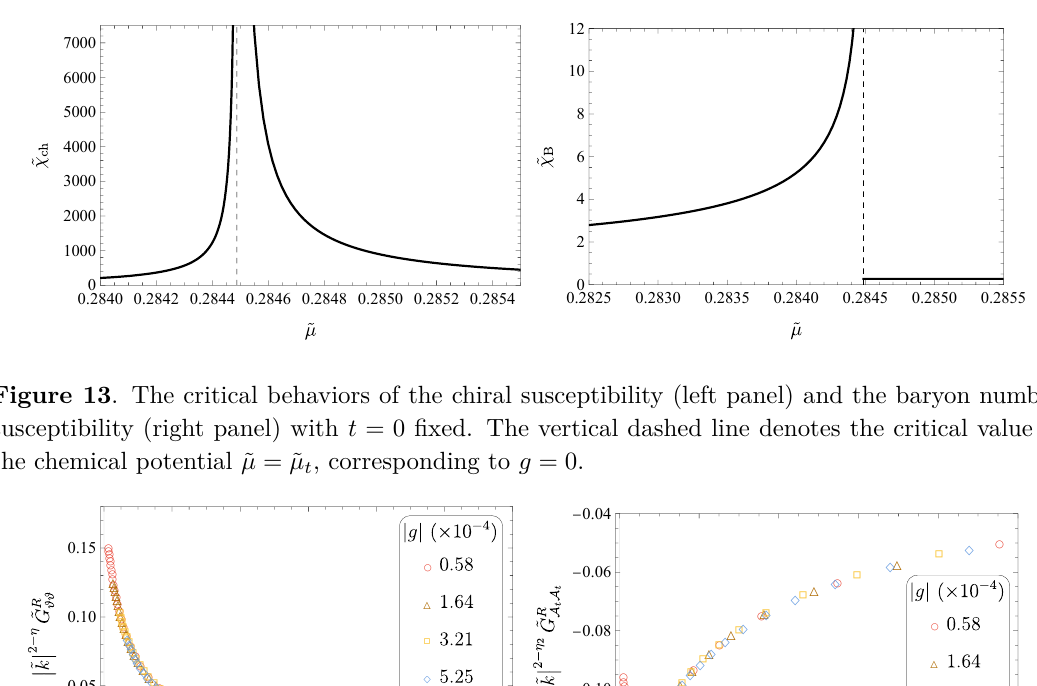
with respect to | g | / ˜ k 1 /ν t ,